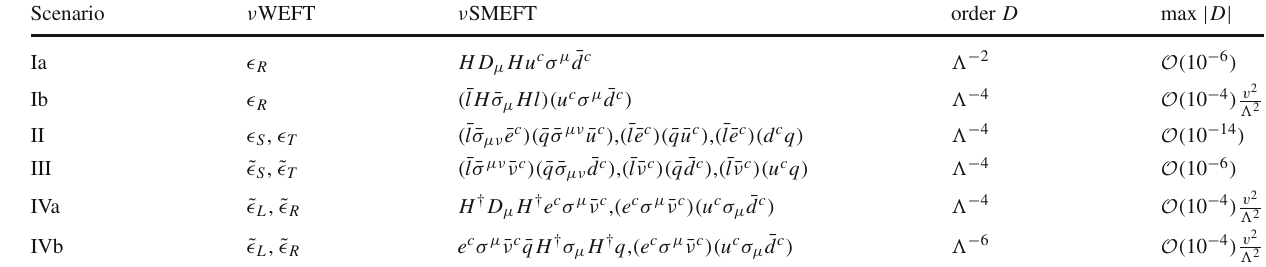
Table 2 Classification of EFT scenarios for generating BSM contri- butions to the D parameter. We list the ν WEFT parameters below the electroweak scale and the ν SMEFT operators above the electroweak scale that define each scenario. We also give the order in the ν SMEFT